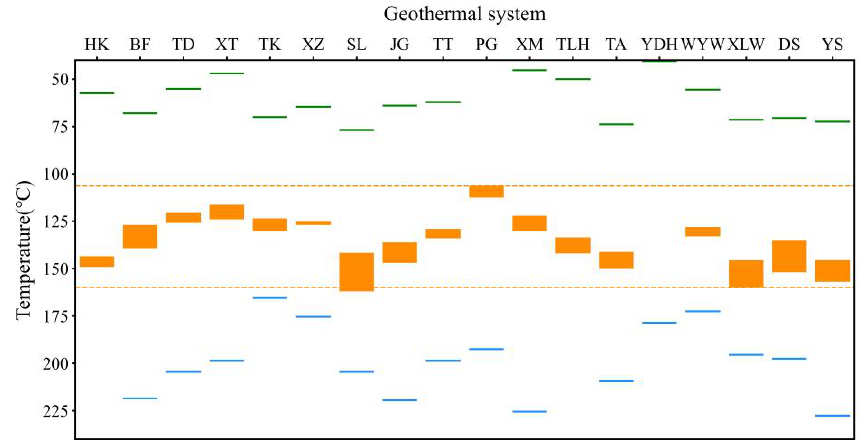
Figure 9. Geothermal reservoir temperatures of different geothermal systems in the study area obtained by different methods. The orange bar graph shows the range of geothermal reservoir temperatures determined by the quartz geothermometer (without vapor loss) and the multiple mineral saturation index method; the blue line indicates the geothermal reservoir temperature obtained from the silica-enthalpy mixing model, and the green line shows the hot water temperature at the surface of the corresponding geothermal system.